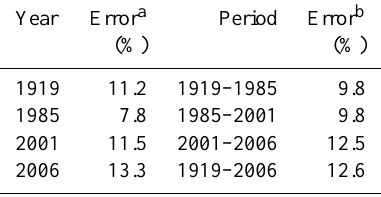
Table 2. Error estimates for area (year) and area change (period).